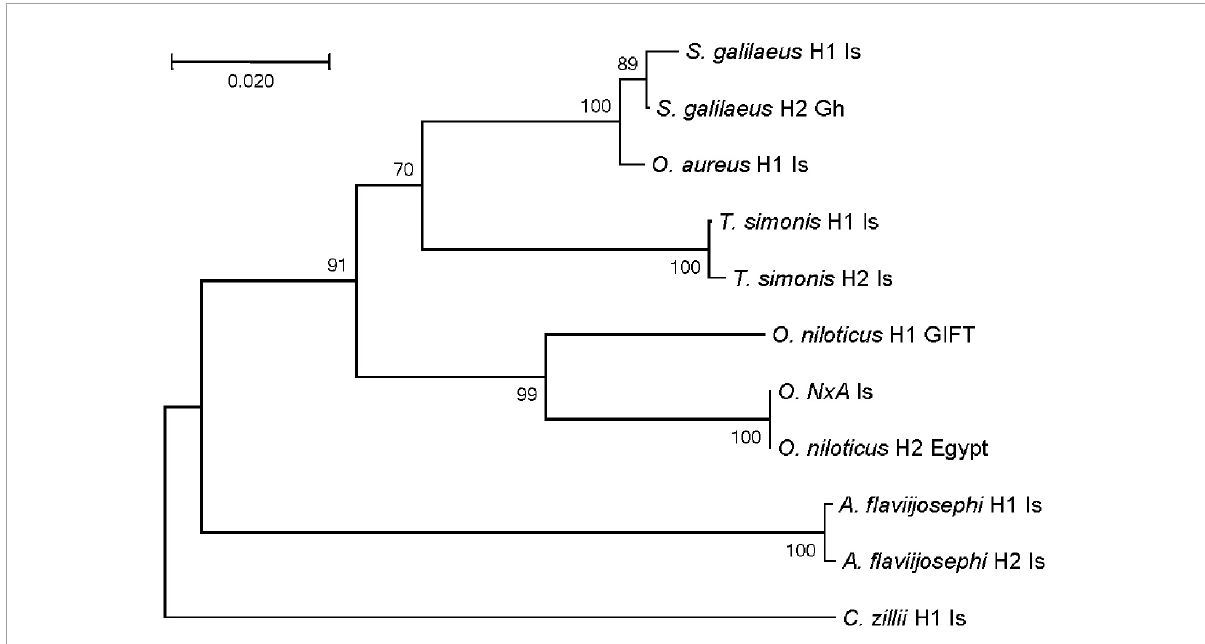
FIGURE2 Unrooted haplotype phylogeny of the six cichlid species based on their COI haplotypes. Numbers next to splits are percent bootstrap support from 1,000 replicates. Next to branch tips are species names, haplotype number, and country of origin (Is, Israel; Gh, Ghana; Egypt and GIFT strain). Sample NxA was morphologically identified as a hybrid between Oreochromis niloticus and Oreochromis aureus